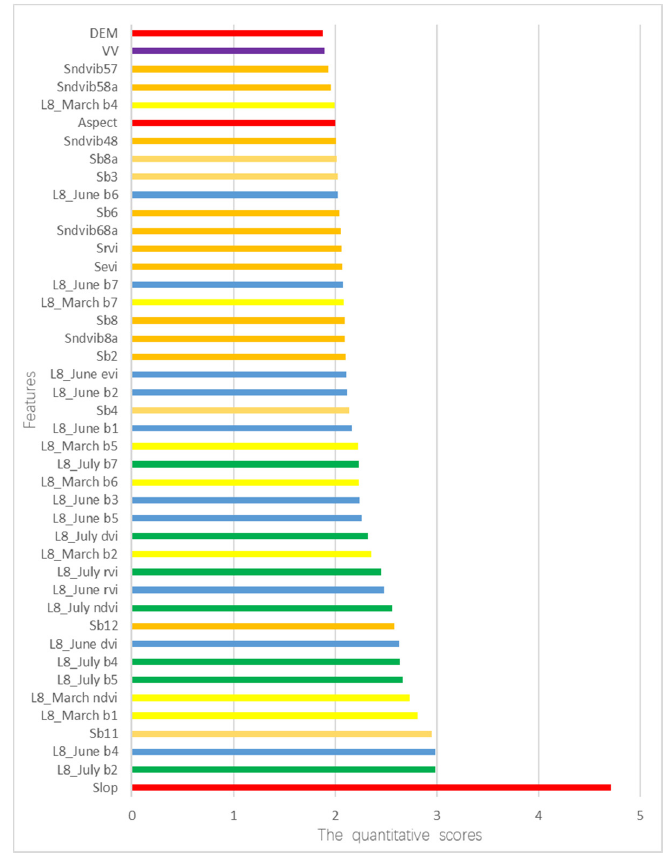
Figure 7. The quantitative scores of each feature in random forest for the final forest type classification Figure (Level-3).